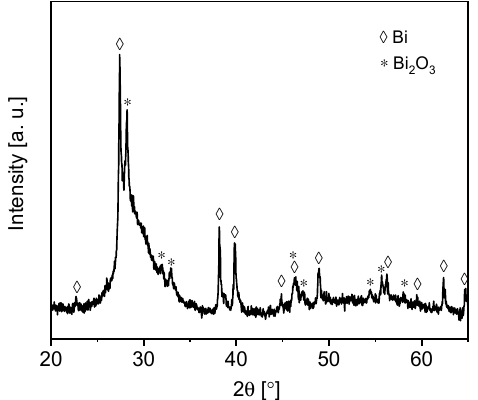
Figure 3. XRD pattern of biochar–BiO x.